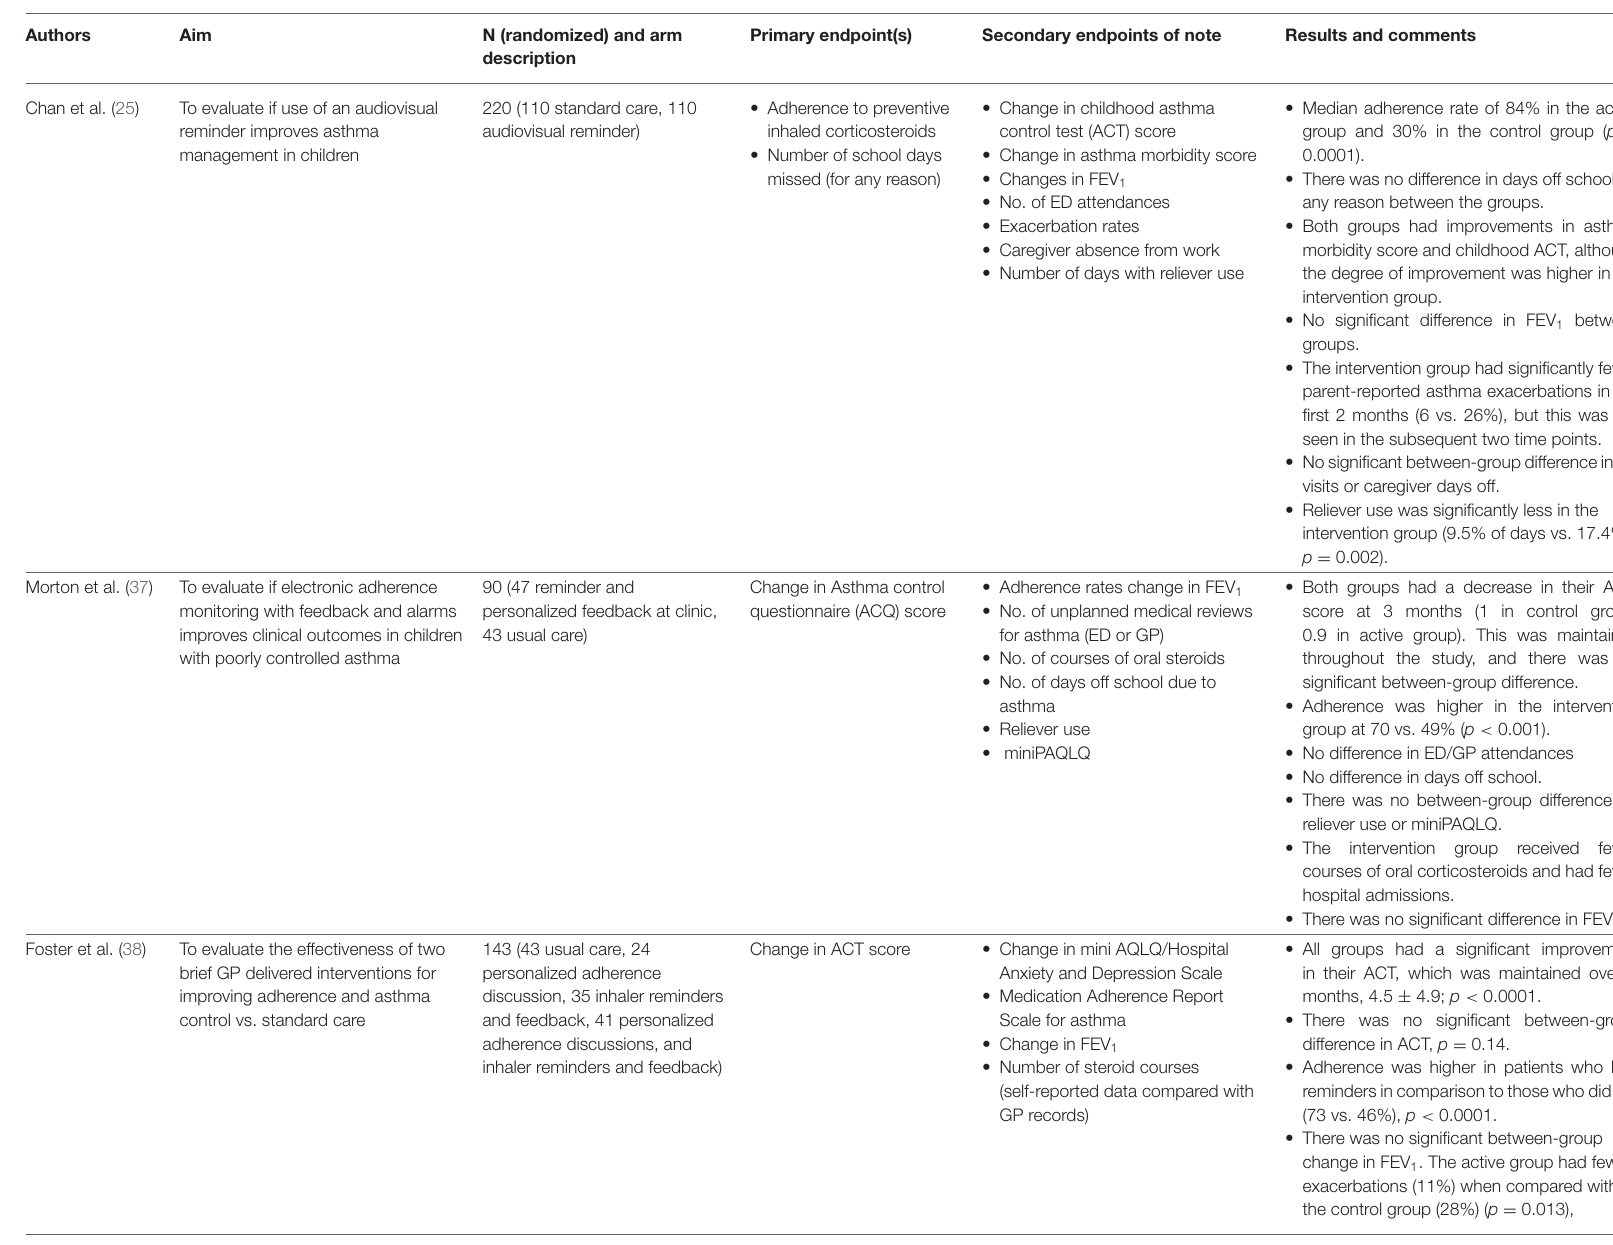
TABLE 2 | Randomized controlled trials evaluating the effect of electronic monitoring devices on disease